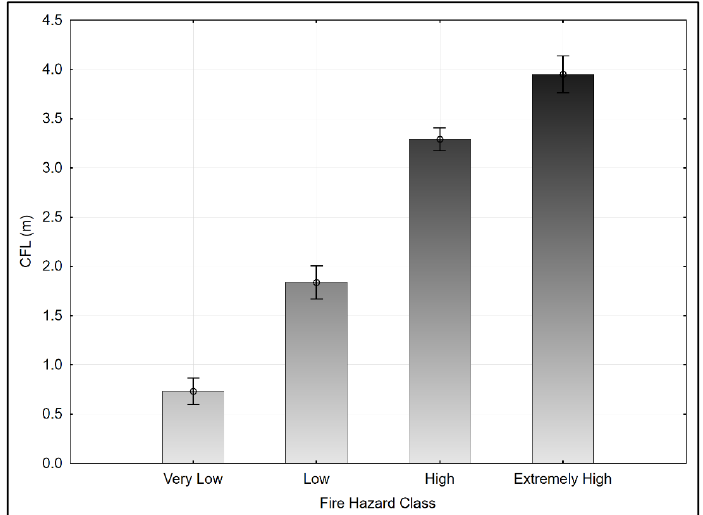
Figure 6. Conditional Flame Length (CFL) of the four identified fire hazard classes estimated using the FDI formula. Vertical bars denote ± one standard error.